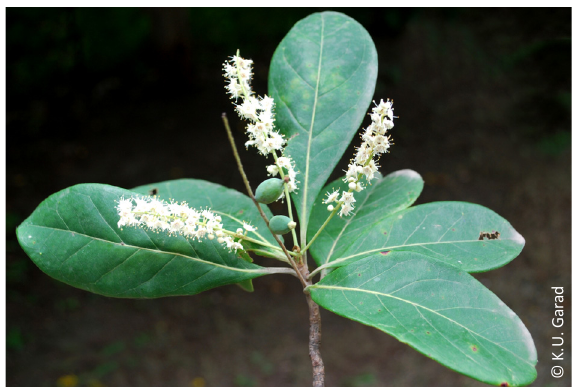
d w a i k G a P . S . © Image 16. Herbarium of Striga asiatica (L.) Kunthz. var. lutea (Lour.)